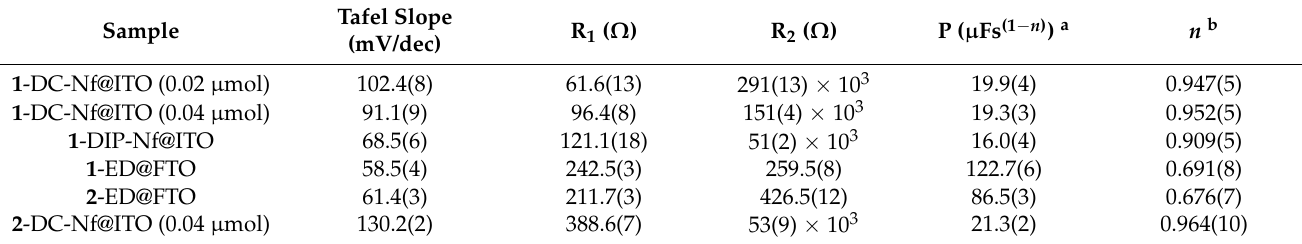
Table 1. Tafel slopes and fitting parameters of the equivalent circuit to the experimental EIS data.